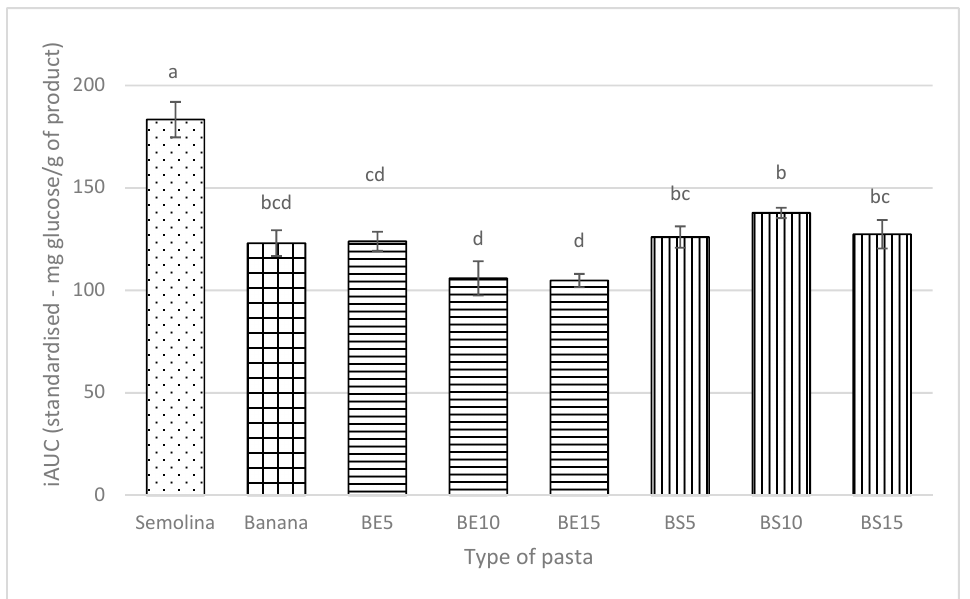
Figure 1. Area under curve (iAUC) values of banana pasta and banana pasta with protein addition (BE5, BE10, BE15 = Banana pasta with 5, 10, 15 g egg white protein/100 g banana flour, BS5, BS10, BS15 = Banana pasta with 15 g soy protein/100 g banana flour) compared to semolina pasta as a control. Different letters above the bars indicate values which are signi fi cantly di ff erent from each other ( p > 0.05), according to Tukey's test.